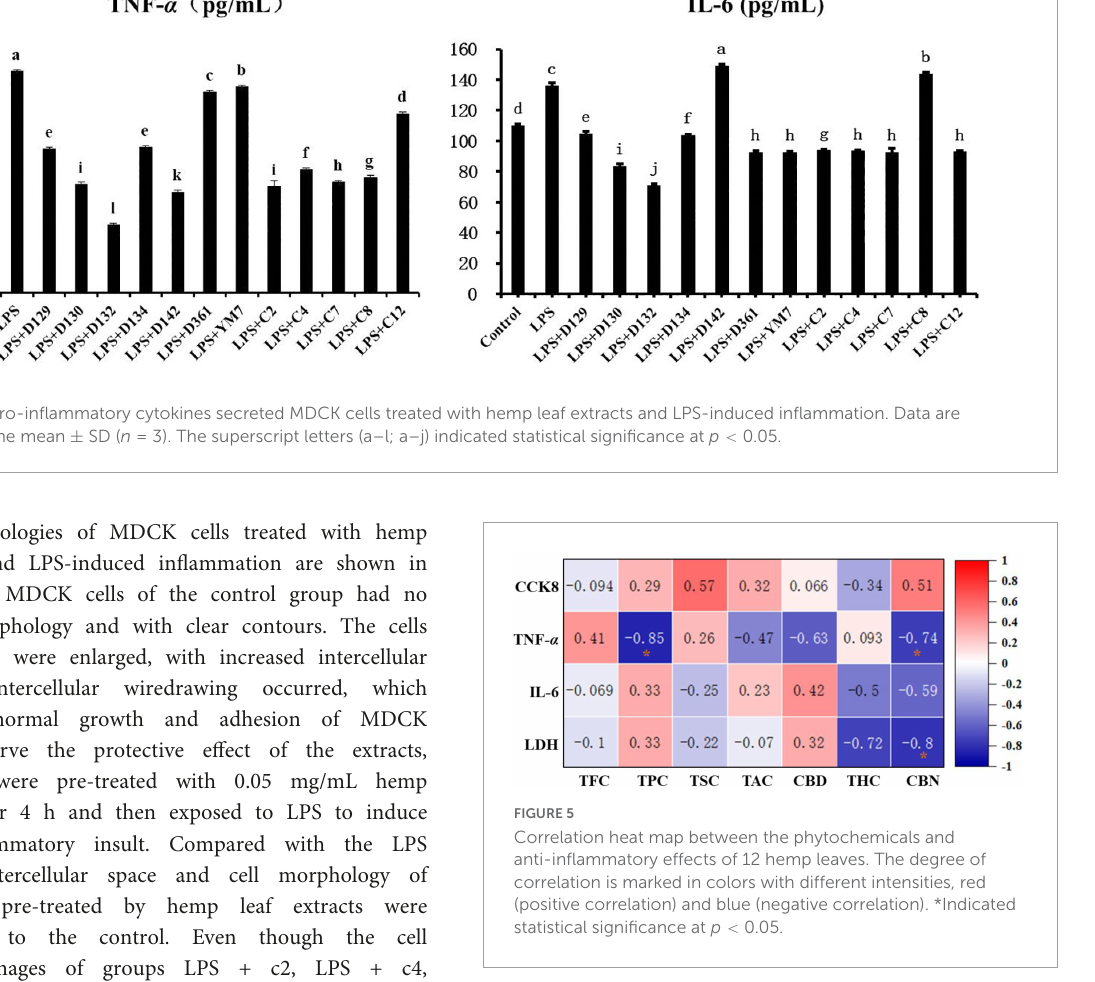
FIGURE5 Correlation heat map between the phytochemicals and anti-inflammatory effects of 12 hemp leaves. The degree of correlation is marked in colors with different intensities, red (positive correlation) and blue (negative correlation). *Indicated statistical significance at p <